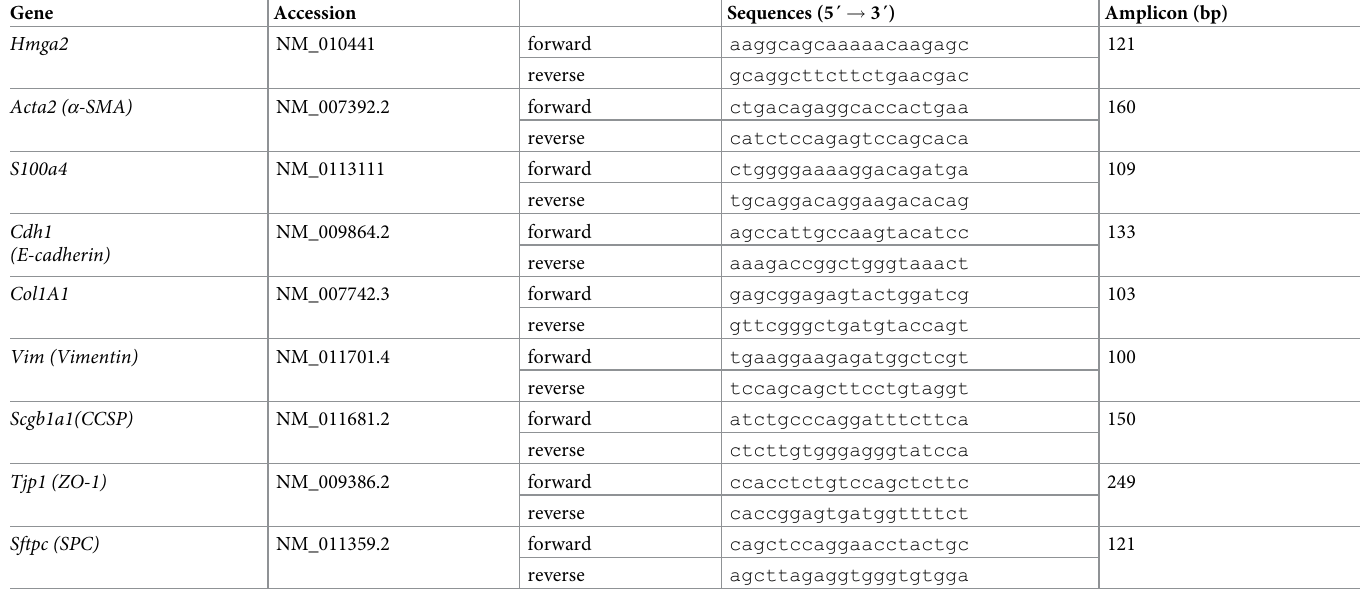
Table 1. Primer sequences used in real time PCR